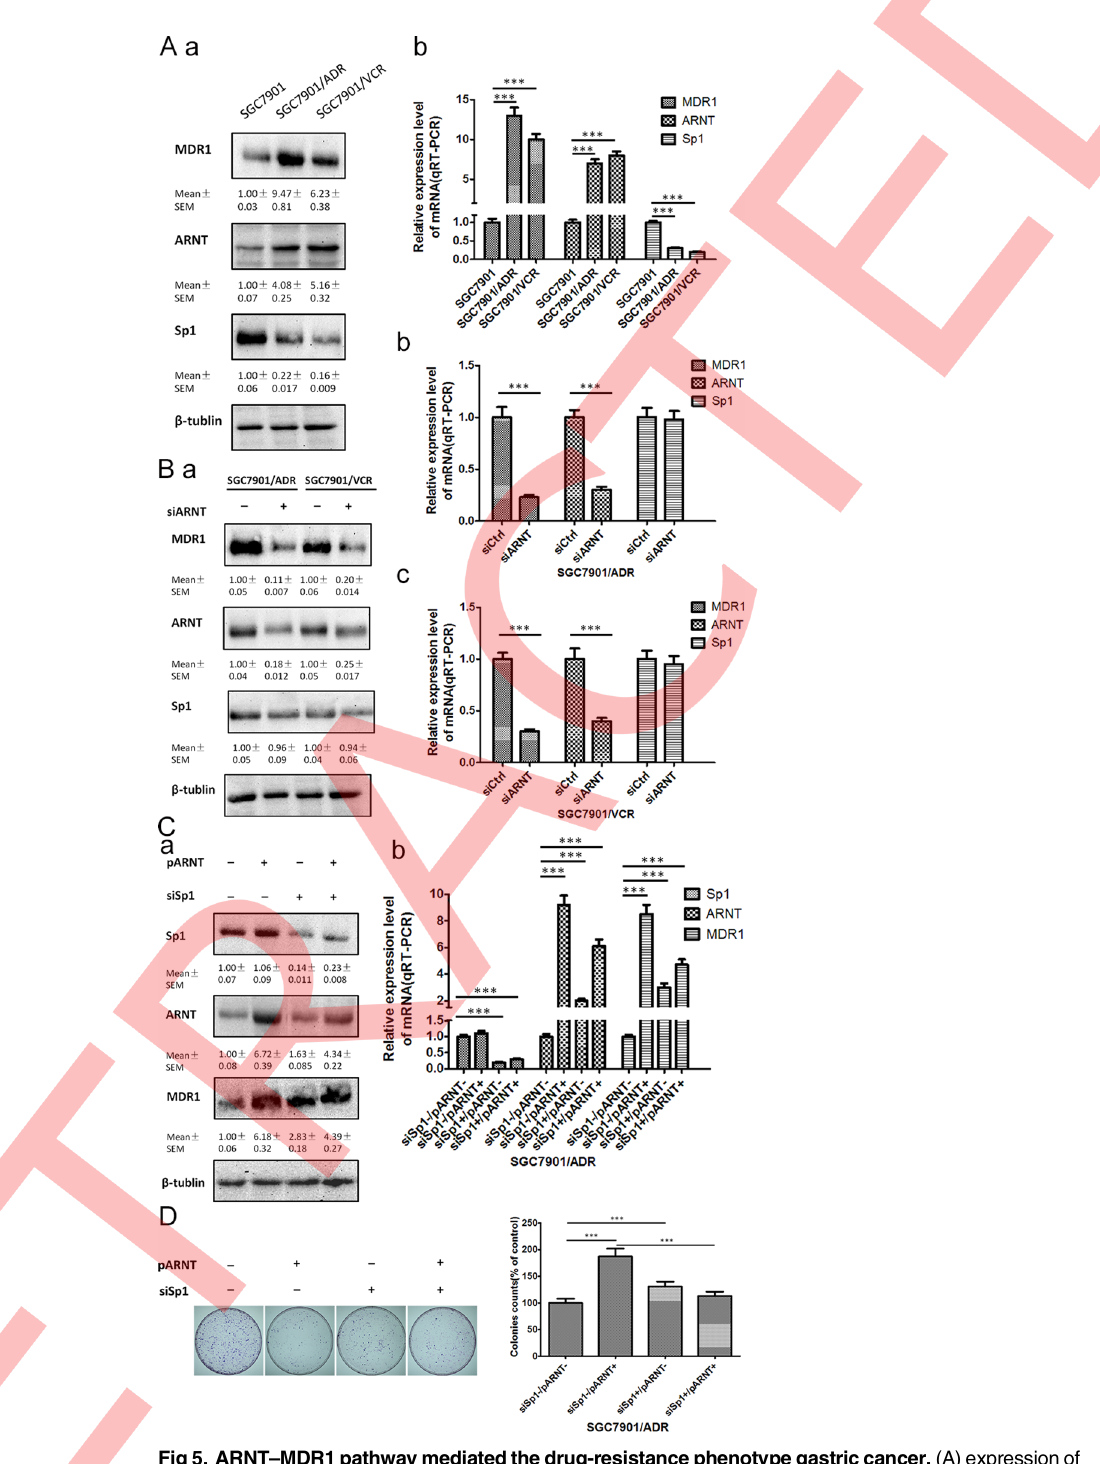
Fig 5. ARNT – MDR1 pathway mediated the drug-resistance phenotype gastric cancer. (A) expression of ARNT, MDR1 and Sp1, a, western blotting, b, qRT-PCR. (B) The effect of siARNT transfection on the expression of ARNT, MDR1 and Sp1, a, western blotting, b, qRT-PCR of SGC7901/ADR, c, qRT-PCR of SGC7901/VCR. (C) The effect of pARNT (ARNT expression vector) and siSp1 transfection on the expression of ARNT, MDR1 and Sp1, a, western blotting, b, qRT-PCR of SGC7901/ADR. (D) Plate colony formation assay of SGC7901/ADR cells with the adriamycin supplement into the culture media (1 μ g/ml) at the designated time. (Data were means of three separate experiments (mean ± SEM), one-way ANOVA analysis, *** p < 0.0001).